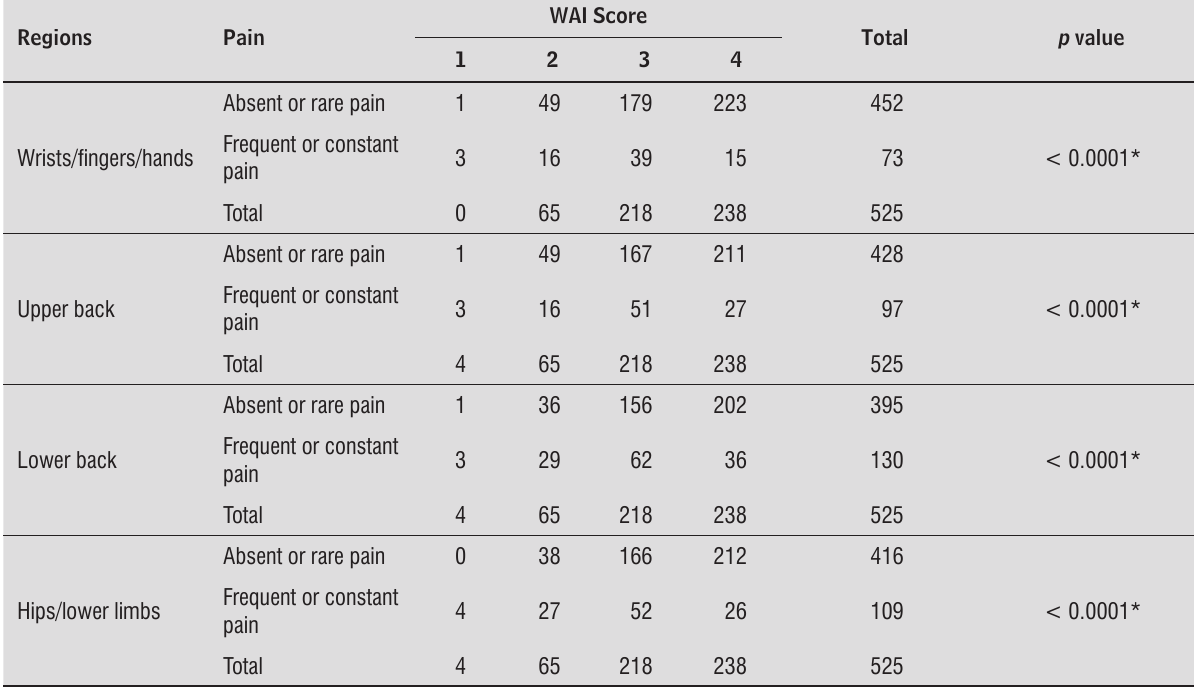
Table 2 - WAI score and presence of pain among Unifal-MG staff (Campus I, Alfenas, Minas Gerais, Brazil)